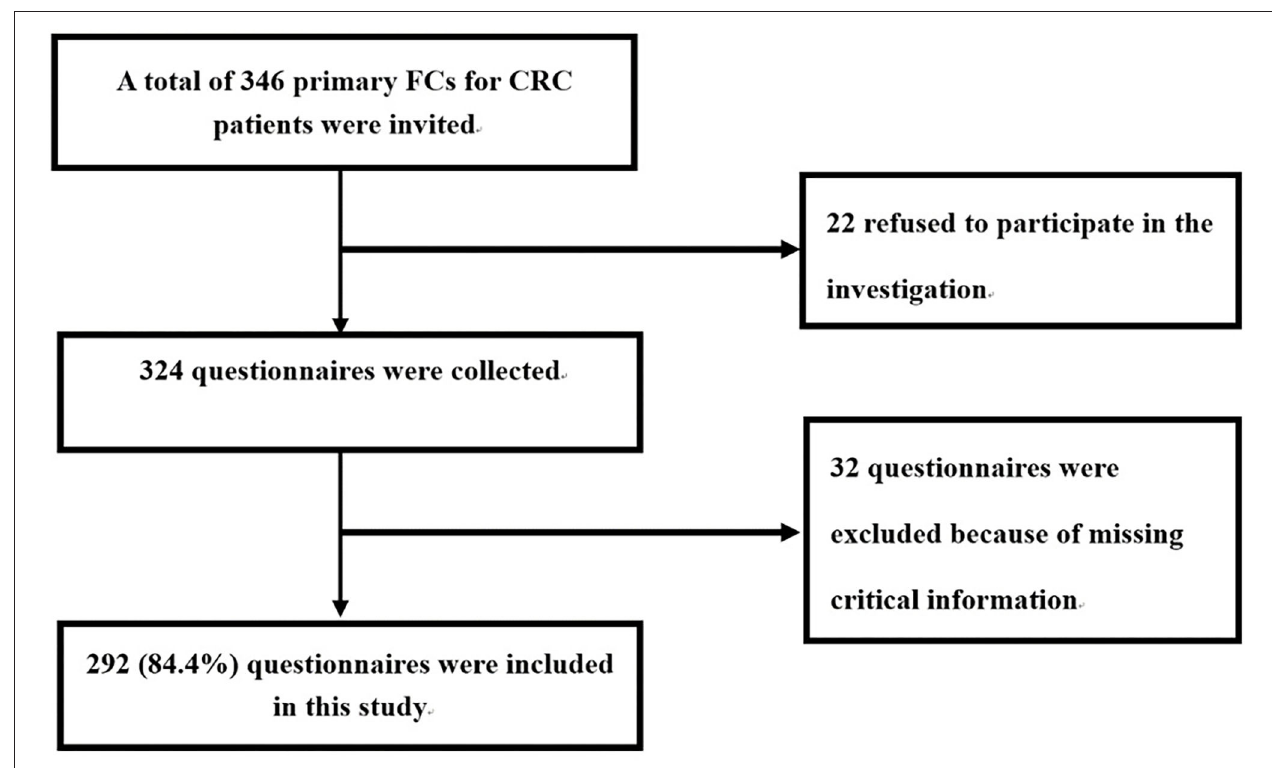
FIGURE 1 | Flowchart of the questionnaire